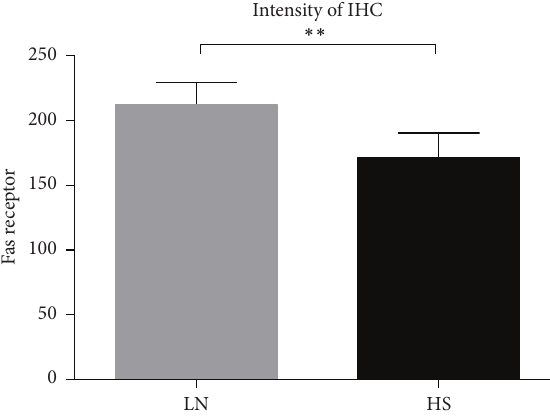
Figure 8: Expression of Fas receptor in renal tissue of LN patients and HS. The expression of Fas was increased in patients with LN ( ∗∗ 𝑃 < 0.007